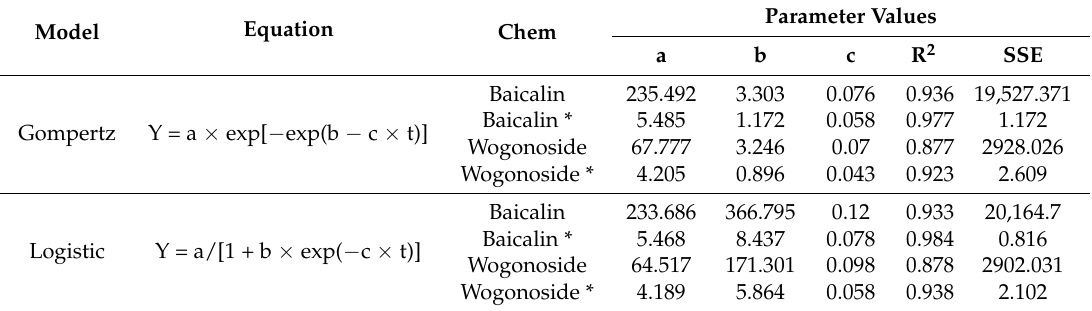
Table 3. Growth models for the accumulation of baicalin and wogonoside in root of S.baicalensis . Model